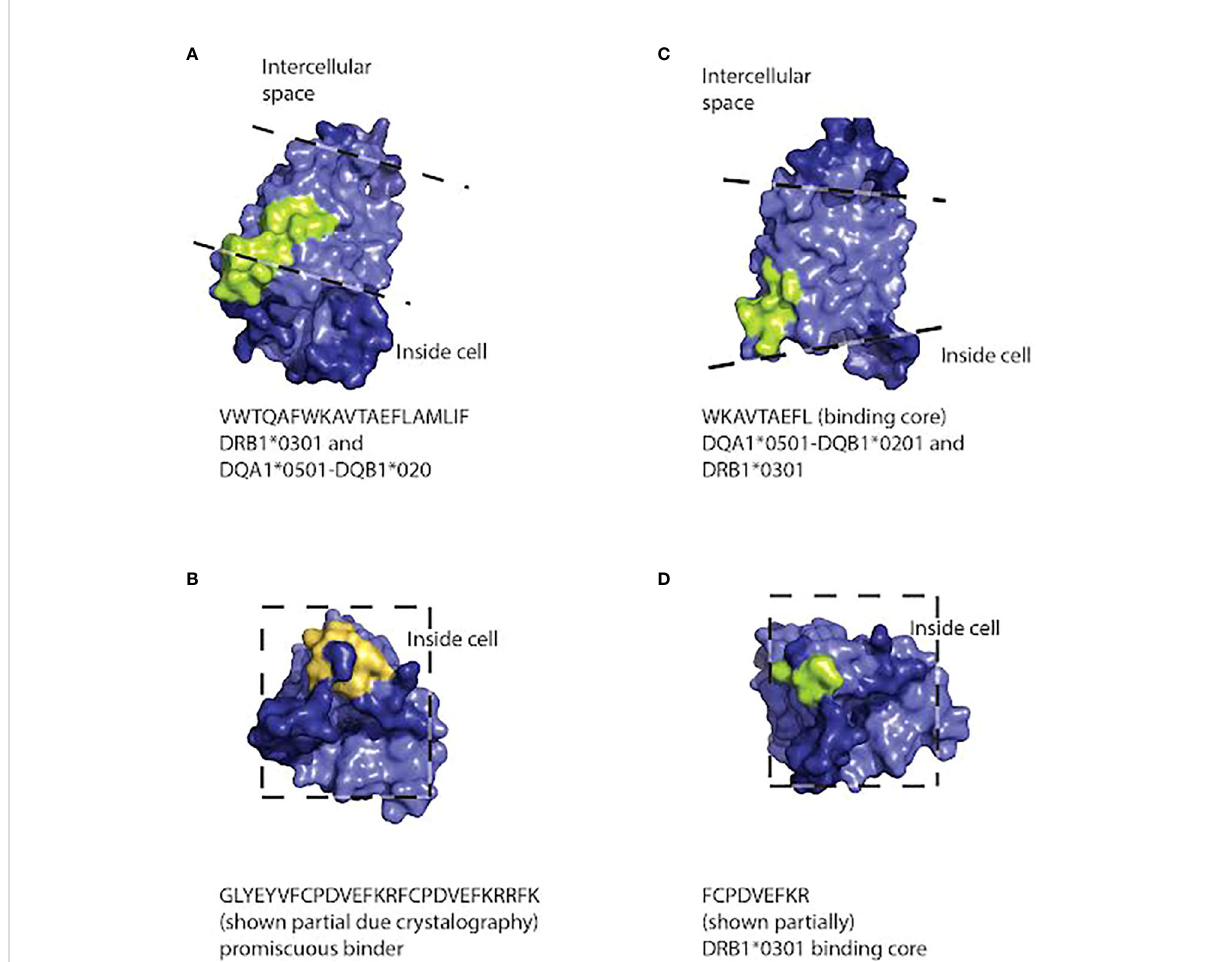
FIGURE 5 Three dimensional space- fi lling diagram of the AQP4 molecule positioned so that peptides capable of binding HLA class II molecules (DRB1*0301, DQA1*0501-DQB1*0201) are visible. The pale blue section of the molecule indicates the intramembrane portion. Dashed lines indicate the approximate position of the extracellular and intracellular surfaces of the cell membrane. Peptides that bind HLA class II molecules strongly are indicated in light green. Promiscuous binders are indicated in orange. Peptide sequences and the HLA molecules binding to them are listed under each model. Peptide sequences: (A) VWTQAFWKAVTAEFLAMLIF binding to DRB1*0301 and DQA1*0501-DQB1*020. (B) GLYEYVFCPDVEFKRFCPDVEFKRRFK binds promiscuously (C) WKAVTAEFL binding DQA1*0501-DQB1*0201 and DRB1*0301 (D) FCPDVEFKR binds